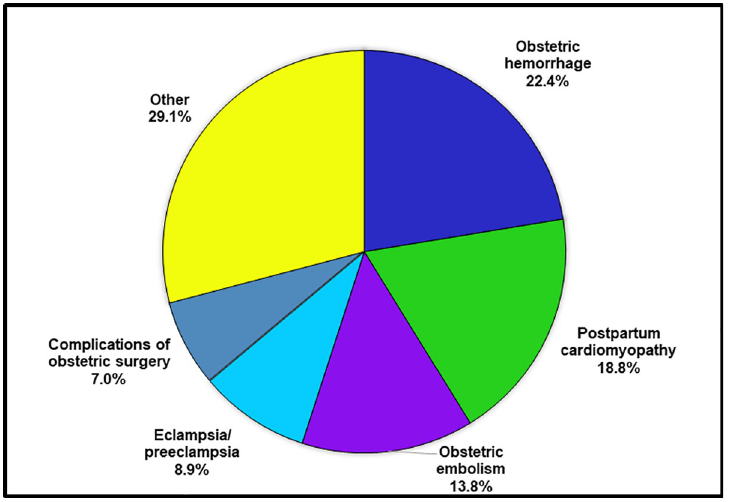
Fig 2. Percent contribution of leading causes of maternal death to the increased risk of maternal mortality for women age 35+, compared to women < 35, United States, 2016–2017. https://doi.org/10.1371/journal.pone.0253920.g002 For women < 35, the leading causes of death were similar to those for the total population. However, for women aged 35+, the leading causes were markedly different. Obstetric hemor- rhage was the leading cause for women aged 35+, and the risk of death from obstetric hemor- rhage was 4 times higher for women aged 35+ then for women < 35 (MRR = 3.93). The second leading cause for women aged 35+ was postpartum cardiomyopathy, with a three times increased risk of death when compared to women < 35 (MRR = 3.13). The third, fourth and fifth leading causes of death for women aged 35+ were obstetric embolism, eclampsia/pre- eclampsia, and other complications of obstetric surgery and procedures, with MRRs of 2.21, 1.73 and 2.58, respectively. The causes of death that contributed the most to the increased risk of maternal death for mothers 35+, compared to those less than 35, were obstetric hemorrhage (22.4%), postpartum cardiomyopathy (18.8%), and obstetric embolism (13.8%) (Fig 2). Compared to women < 35, late maternal mortality rates were markedly higher for women aged 35+ (MRR = 1.79) (Fig 3). For late maternal deaths, the leading cause of death was